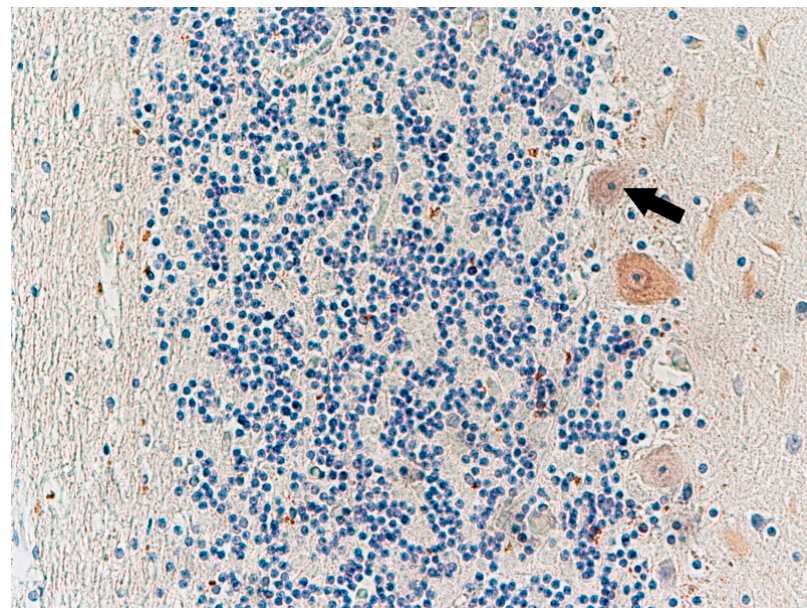
Figure 10. Case no. 1 Cerebellar cortex. Attenuated immunohistochemical reaction with calbindin ‐ D ‐ 28k antibody in Purkinje cells (arrow). Homogenisation changes of Purkinje cells. Magnification 200×.